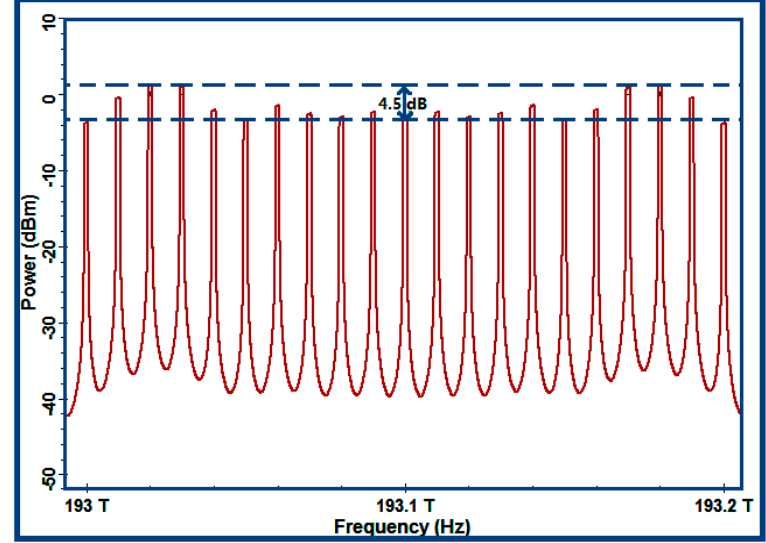
Figure 5. Multi-wavelength optical comb (21 channels).